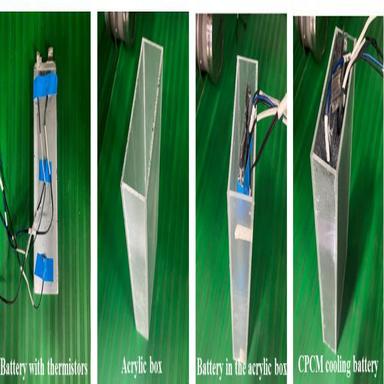
Assembly process of the CPCMs-cooled battery.